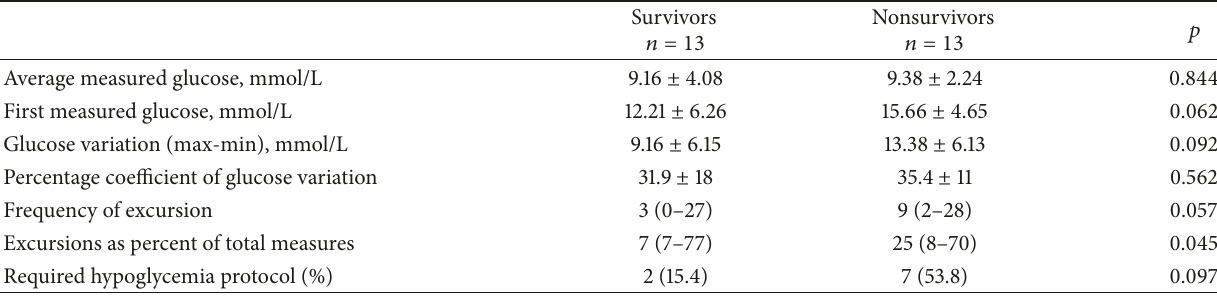
Table 2: Differences between survivors and